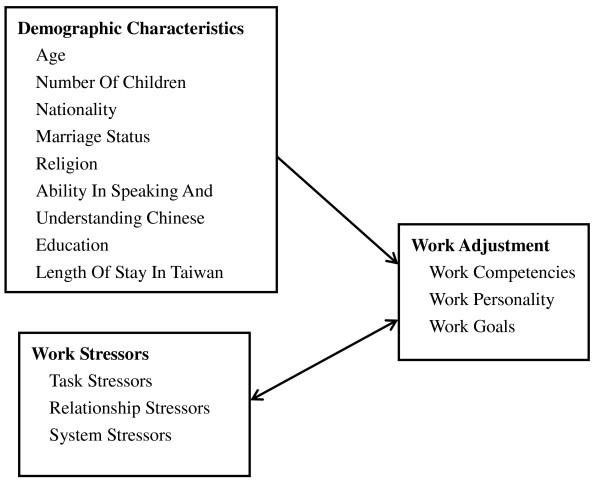
Research Framework.